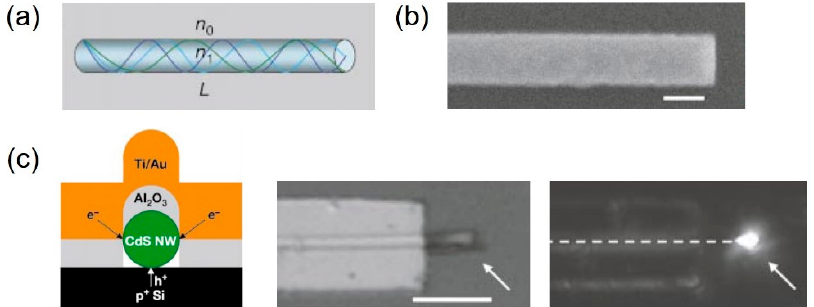
Figure 7. Electrically driven single CdS nanowire (NW) nanolasers. ( a ) An NW with length L and index n 1 as a stand-alone optical cavity. ( b ) SEM image showing a clean and vertical facet for high reflection. ( c ) Schematic of the cross-section of the device showing carrier injection paths through the NW (left). White light (middle) and electroluminescence images (right) of the device captured by CCD camera. White arrows indicate the exposed CdS NW ends [36]. Figure reproduced with permission from Springer Nature Limited.